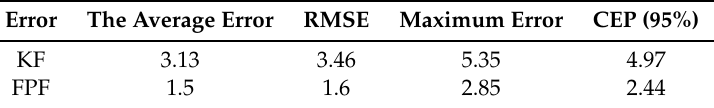
Table 1. Position errors for KF and FPF (m).